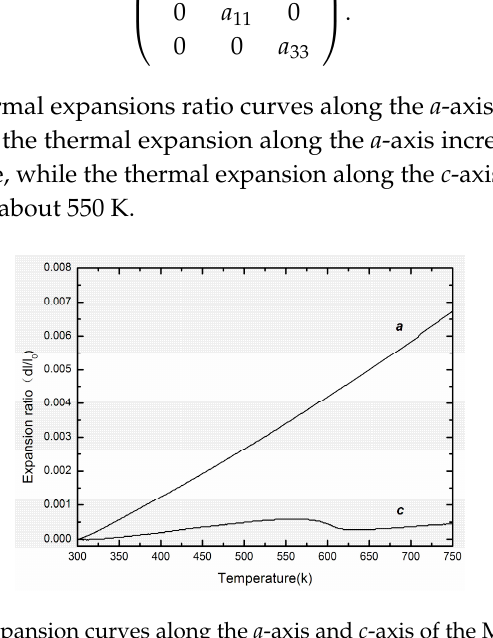
Figure 6. Thermal expansion curves along the a -axis and c -axis of the Mg: 7 LiNbO 3 crystal. The thermal expansion coefficient can be calculated using Equation (6).